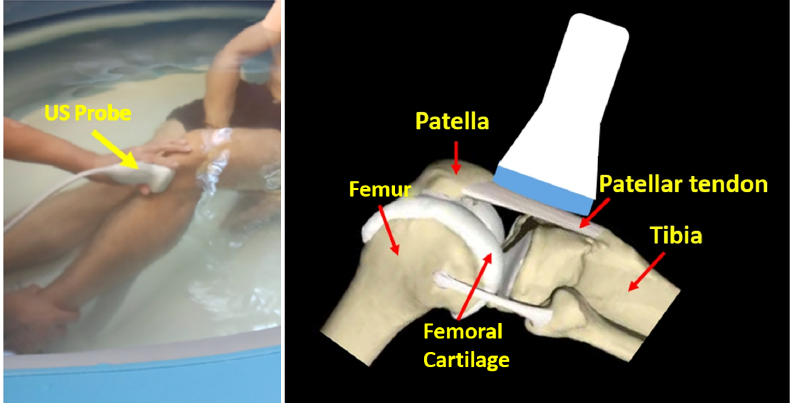
Figure 1. US probe positioning during the knee scan with the corresponding schematic in sagittal